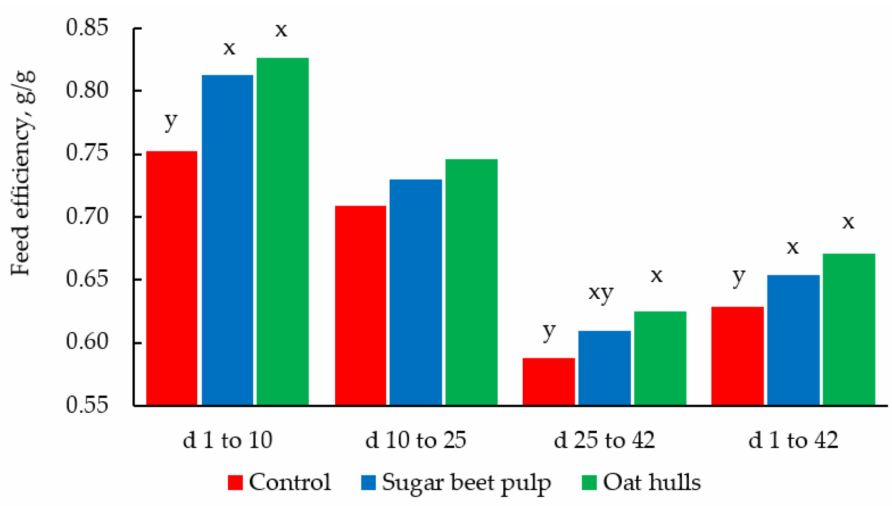
Figure 4. Feed efficiency (g/g) of broiler chickens fed diets containing sugar beet pulp or oat hulls from 1 to 42 d post hatching [62]. Means within the period without a common letter differ ( p <